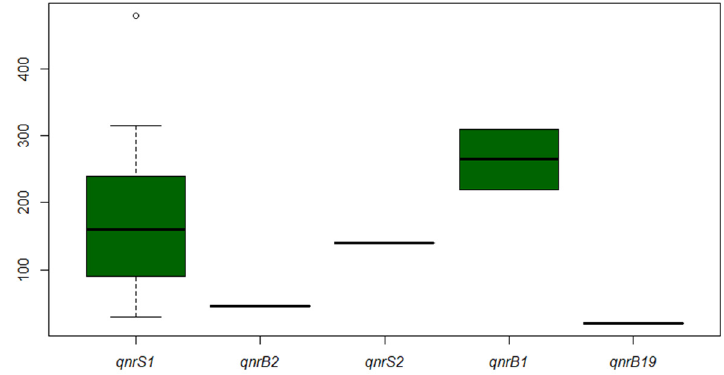
Figure 3. Boxplots of the size distribution of analysed plasmids harboring qnr , estimated through S1-PFGE. The white circle represents an outlier.